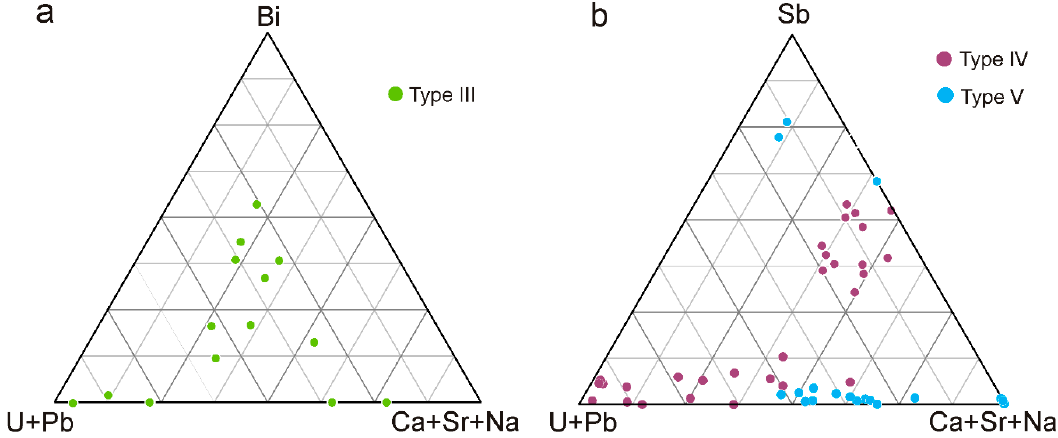
Figure 20. Compositional plot of the pyrochlore-supergroup minerals from the Giraúl pegmatites. ( a ) U + Nb – Bi – Ca + Sr + Na; ( b ) U + Nb – Sb – Ca + Sr + Na.